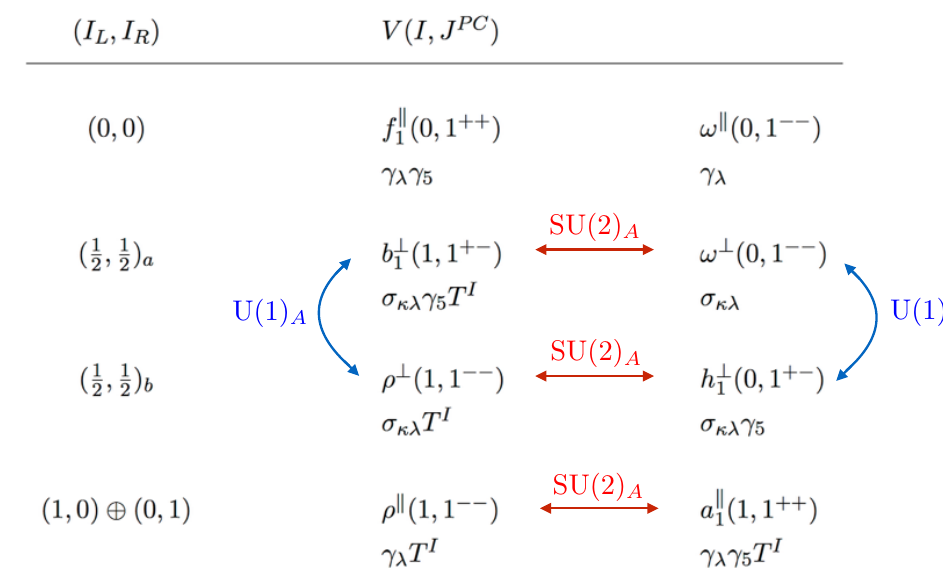
Figure 2 . Lowest-lying particles coupling to vector and tensor currents of isosinglet- and isotriplet- type, making a total of 16 vector mesons. For simple comparison, we use the same graphic pre- sentation with similar notation as used in [62]. The interpolating operators are de(cid:12)ned in (3.1) where the coupling to the states is speci(cid:12)ed further below. In the restoration limit (2.7), one would expect a 4-, 4- and 6-plet degeneracy by the restoration of the SU(2) A (red arrows). In the case where U(1) A (blue arrows) symmetry is also restored, this leads to a 8- and 6-plet degeneracy. The actual degeneracy is found to be larger [62], compatible with an emergent SU(4) [70] (or even SU(4) SU(4) [71]) (cid:2)